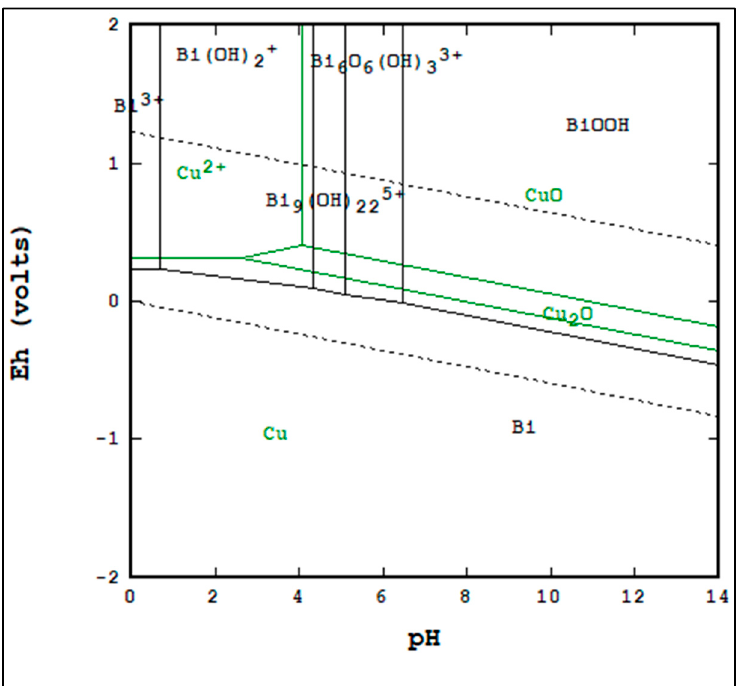
Figure 1. Copper (0.173 M) and bismuth (0.00178 M) Pourbaix diagram overlay .